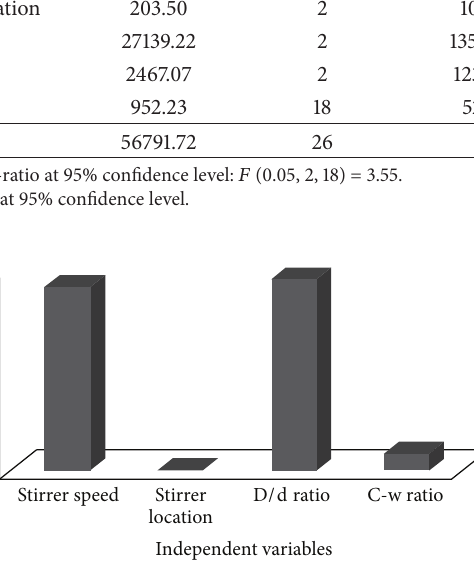
Figure 7: % of contribution of each design variables.